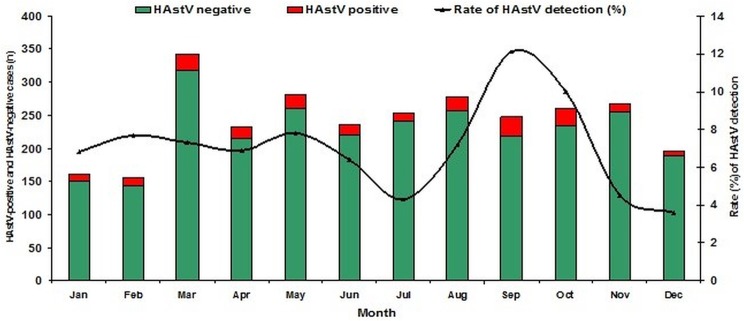
Seasonality of HAstV in cases of acute diarrhea.
Laboratory-based HAstV in three Brazilian regions, between 2005 and 2011. The rate of HAstV detection by month and number of HAstV-positive samples. Each month represents cumulative observations.